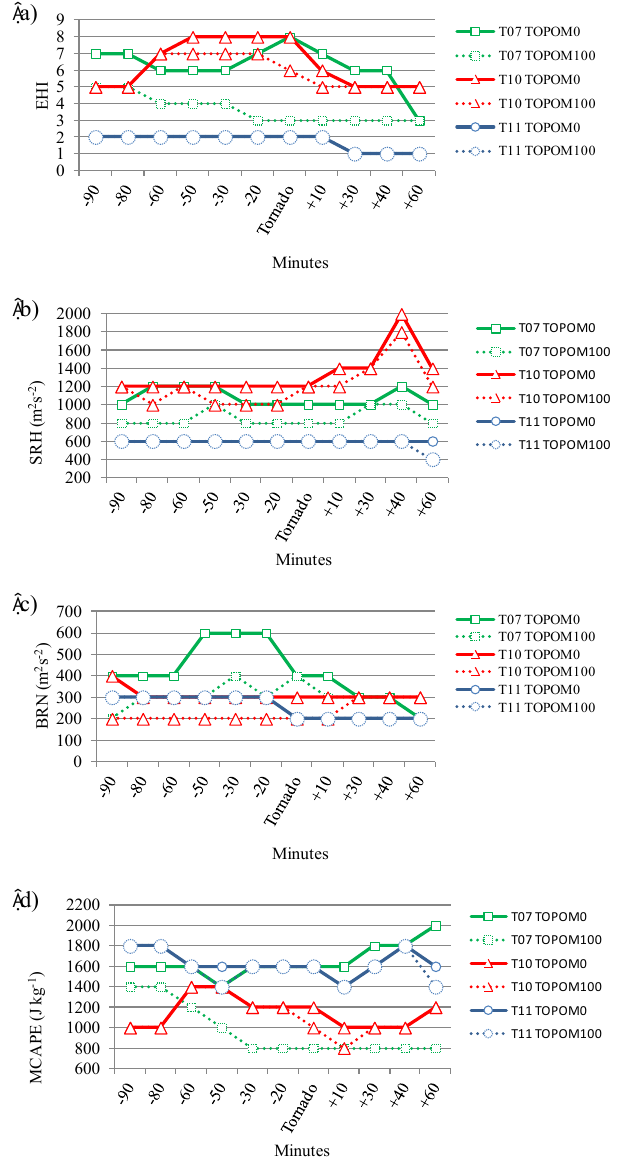
Figure 8. Graphics (a–d) illustrating TOPOM0 (solid lines) and TOPOM100 (dotted lines) simulations results 90min prior to and 60min after tornadogenesis for EHI (a) , SRH (b) , BRN (c) , and MCAPE (d) for every tornadic case study. The results of T07, T10, and T11 simulations are illustrated with green lines with squares, red lines with triangles, and blue lines with circles, respectively. All values for the two sets of simulations (TOPOM0 and TOPOM100) illustrate the values of instability indices in radii of less than 20km from the tornadogenesis location. The SRH analysis of T07 TOPOM0 (Fig. 8b, solid green line with squares) numerical simulation illustrates that max- imum values fluctuate between 1000 and 1200 m 2 s − 2 prior to and after tornadogenesis. Due to the eastern propagation of a cell area with high values, this is depicted in Fig. 9e